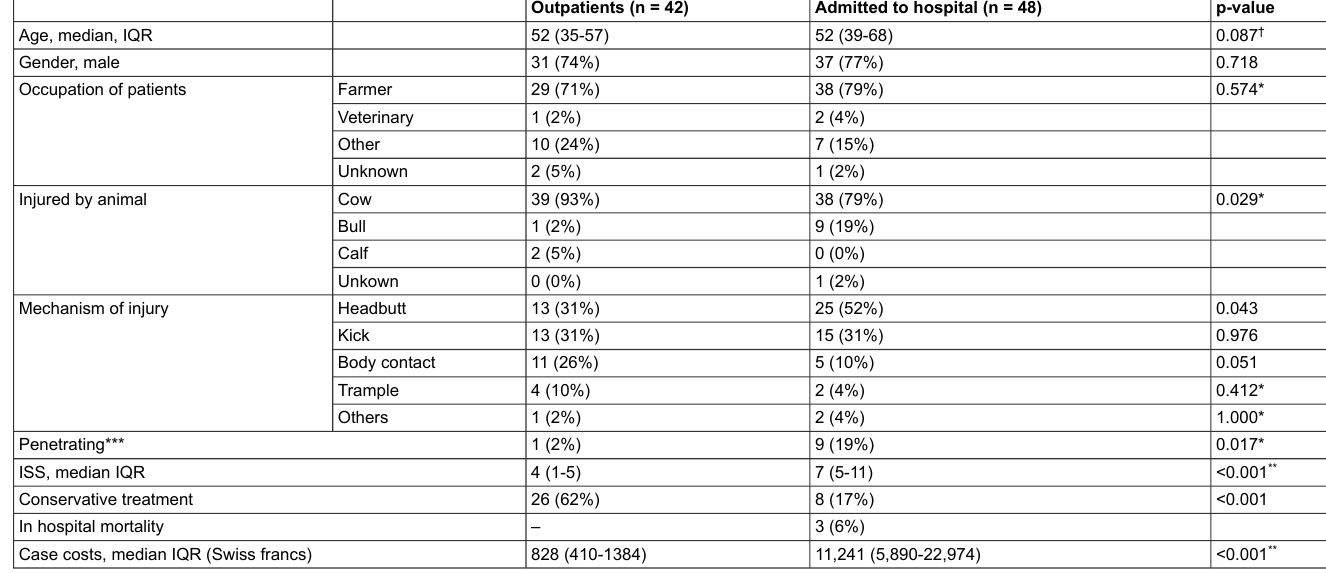
Table 4: Comparison of patients treated as outpatient and patients admitted to hospital. Four patients were transferred from our emergency department to outside hospitals and were not considered for this analysis. Pearson chi-square test unless indicated